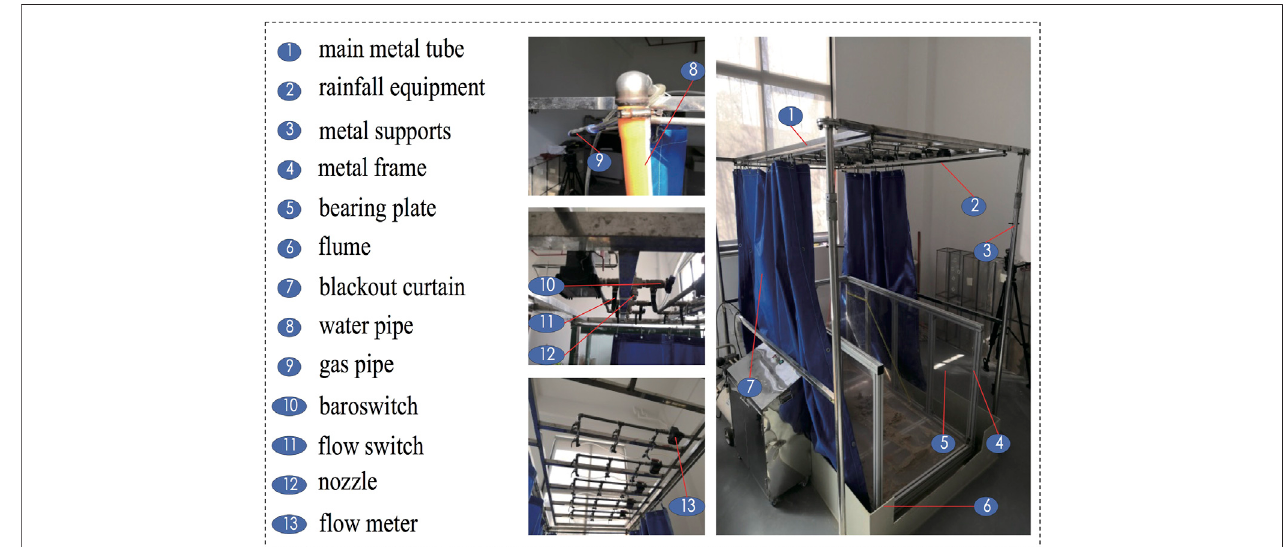
FIGURE 1 | Rainfall device model.